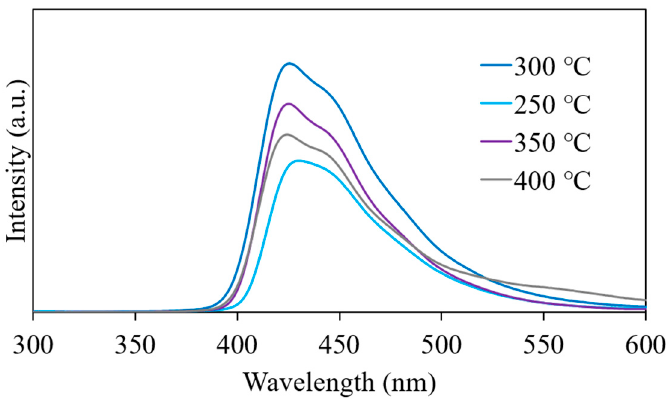
Figure 9. X-ray-induced radioluminescence spectra obtained for the liquid scintillator incorporating PHA-modified ZrO 2 nanoparticles synthesized at 250, 300, 350, and 400 °C.